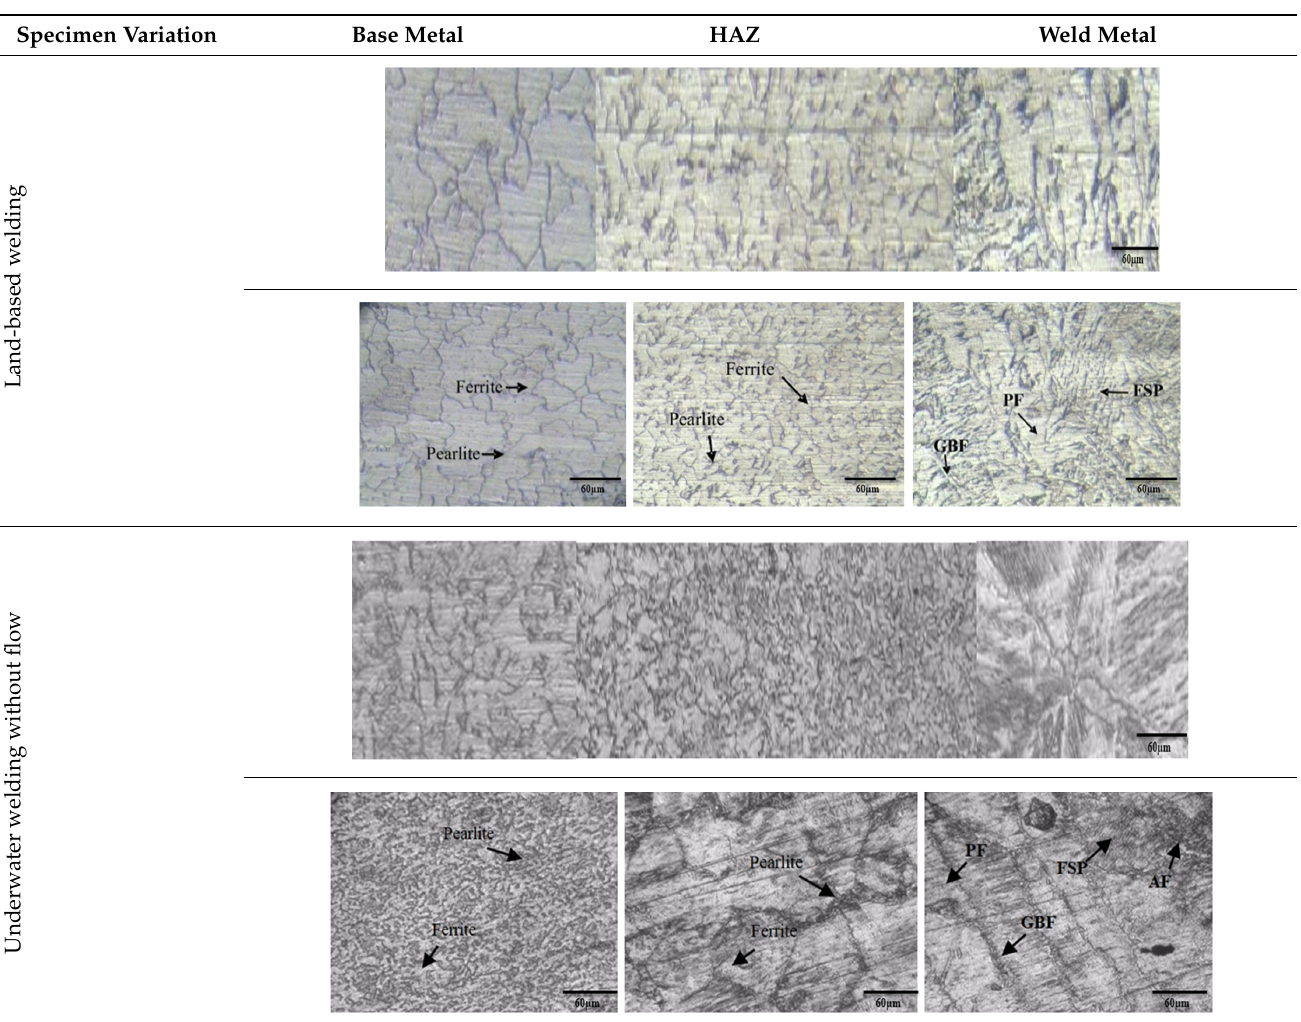
Table 5. Comparison of micro-test results under different welding types.